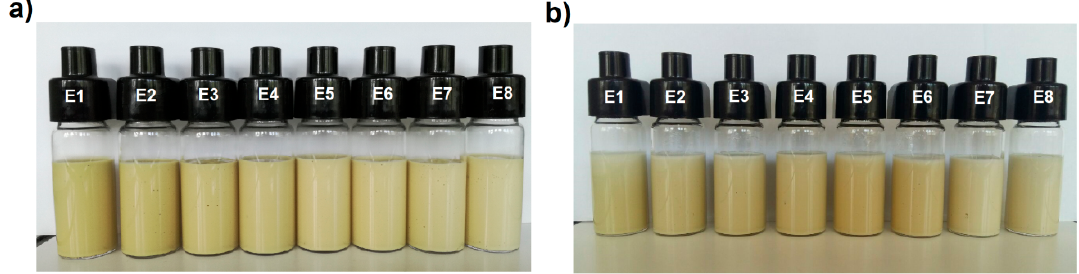
Figure 1. Acid value (AV) of the raw fats and interesterified fat blends. Different letters indicate statistically significant difference ( p < 0.05).